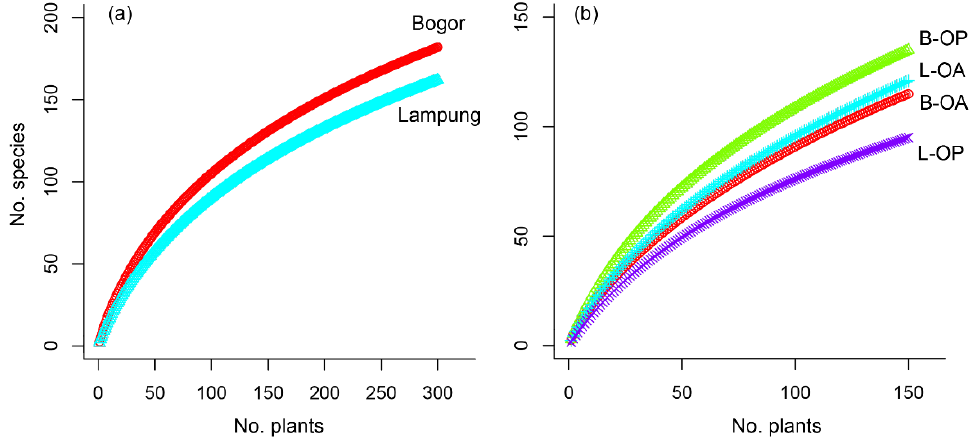
Figure 2. Species accumulation curve of insect diversity based on the number of C. odorata plants. ( a ) Insect diversity between Bogor and Lampung, ( b ) insect diversity between different land-use types in Bogor and Lampung. B-OP = oil palm in Bogor, B-OA = open area in Bogor, L-OP = oil palm in Lampung, L-OA = open area in Lampung.